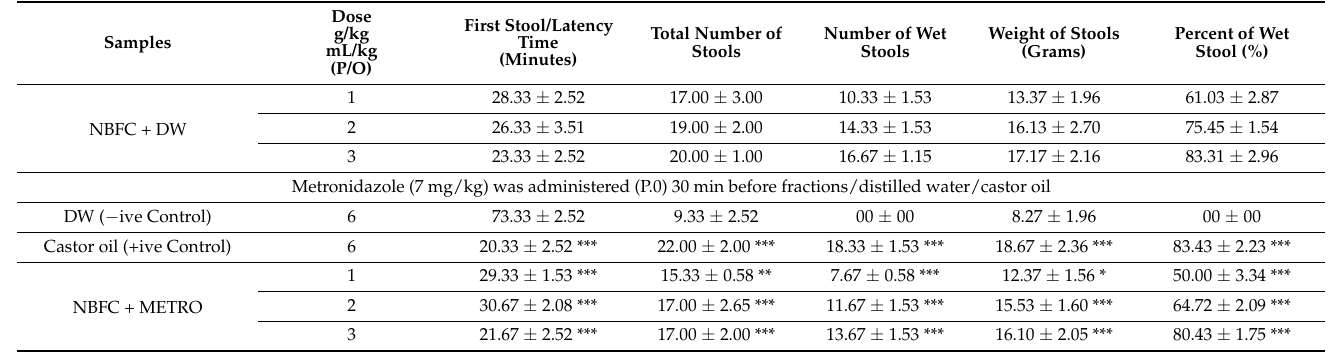
Table 6. Diarrheal/laxative activity of n-butanol fraction C. tinctoria in metronidazole induced constipa-tion in